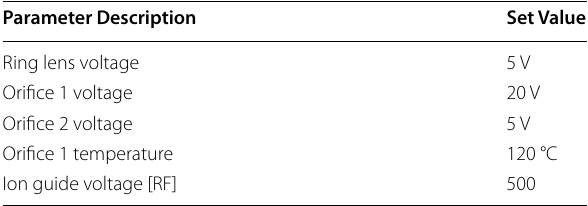
Table 2 AccuTOF-DART 4G mass spectrometer parameters Parameter